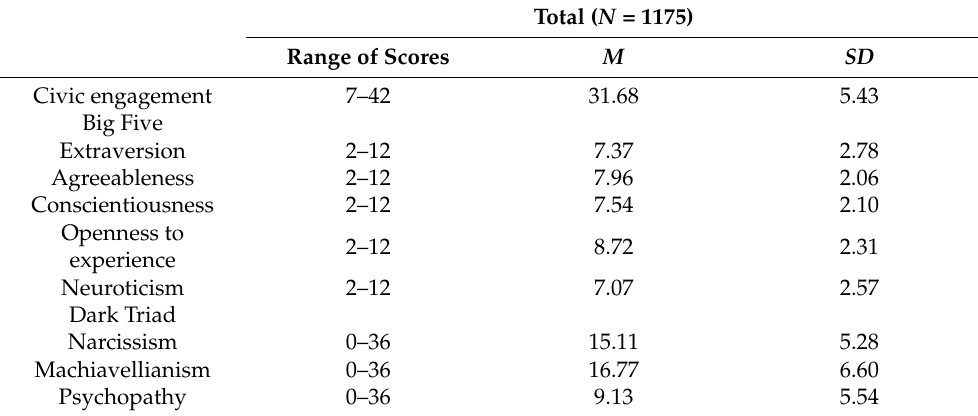
Table 1. Means and Standard Deviations for Civic Engagement, Dark Triad, and Big Five.